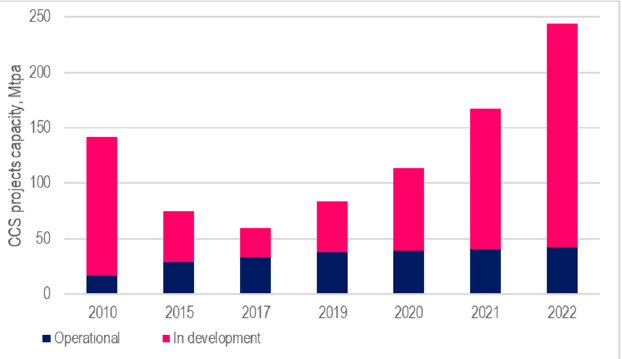
Figure 7. Capture capacity of ongoing and planned CCS projects adapted from [46,170].